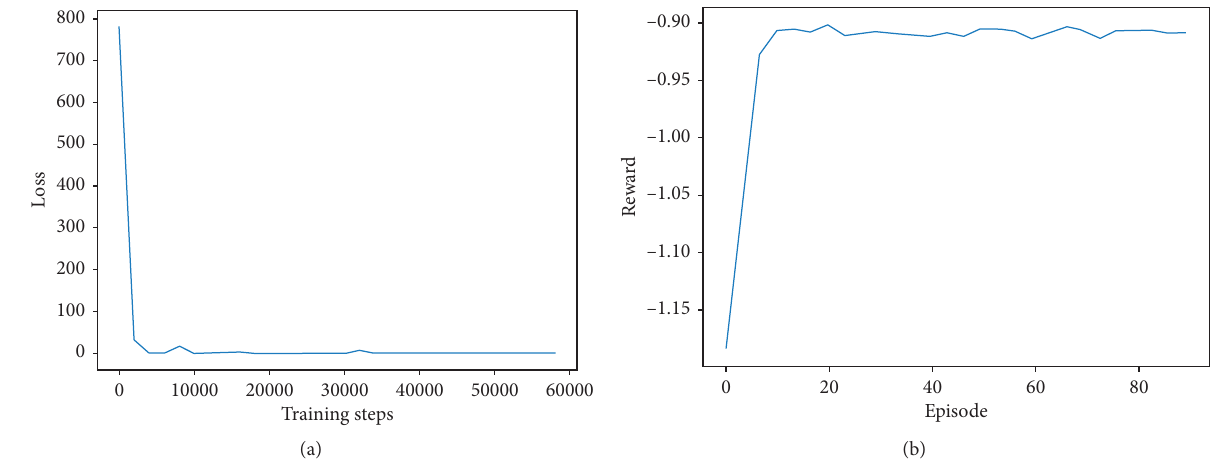
Figure 5: Trend of the loss and the trend of the reward. (a) Loss trend. (b) Reward